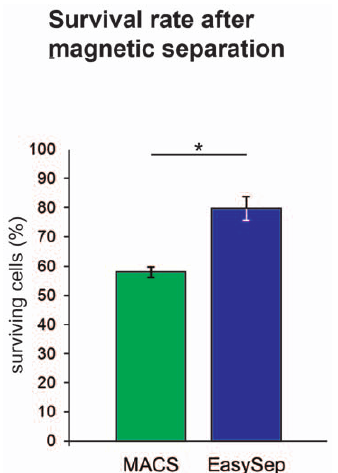
Figure 1. Survival rates after MACS (green column) and EasySep (blue column) separation. For the MACS separation, about 40% and for the EasySep separation about 20% of the initially applied cells were lost. The difference between the survival/mortality rates obtained by both separation methods (n=16 for each separation method) was significant (p ,